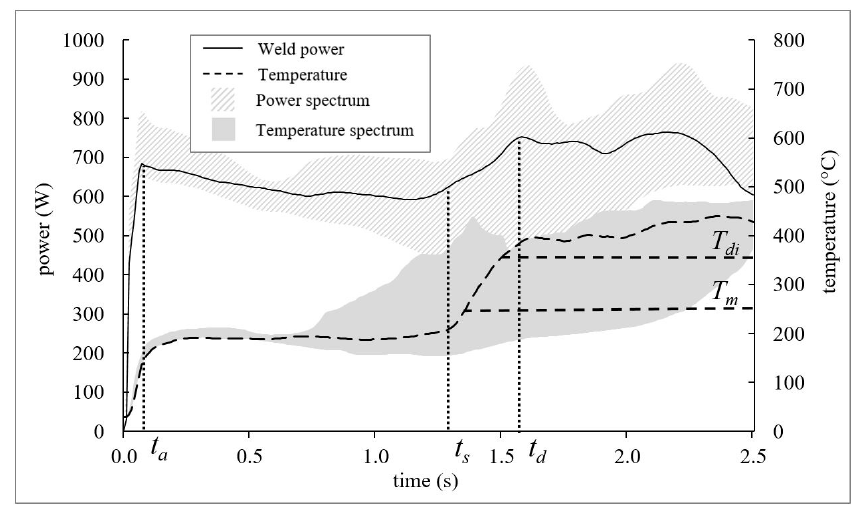
Figure 8. The power and temperature curves of the uncontrolled welds case UC-3. Illustrating the characteristic times and temperatures during the DUS welding.